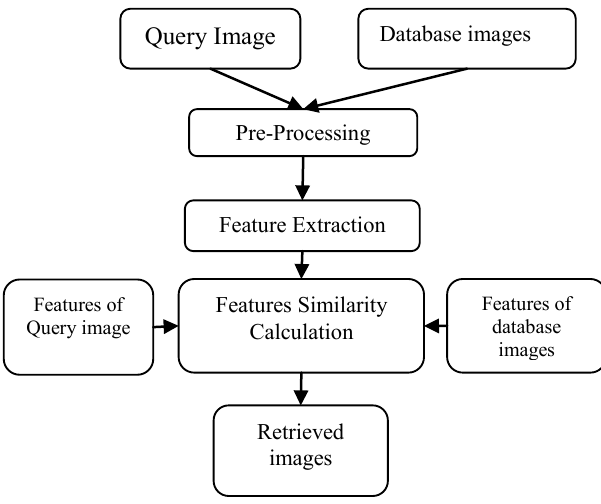
Figure 1. Basic block diagram of CBIR